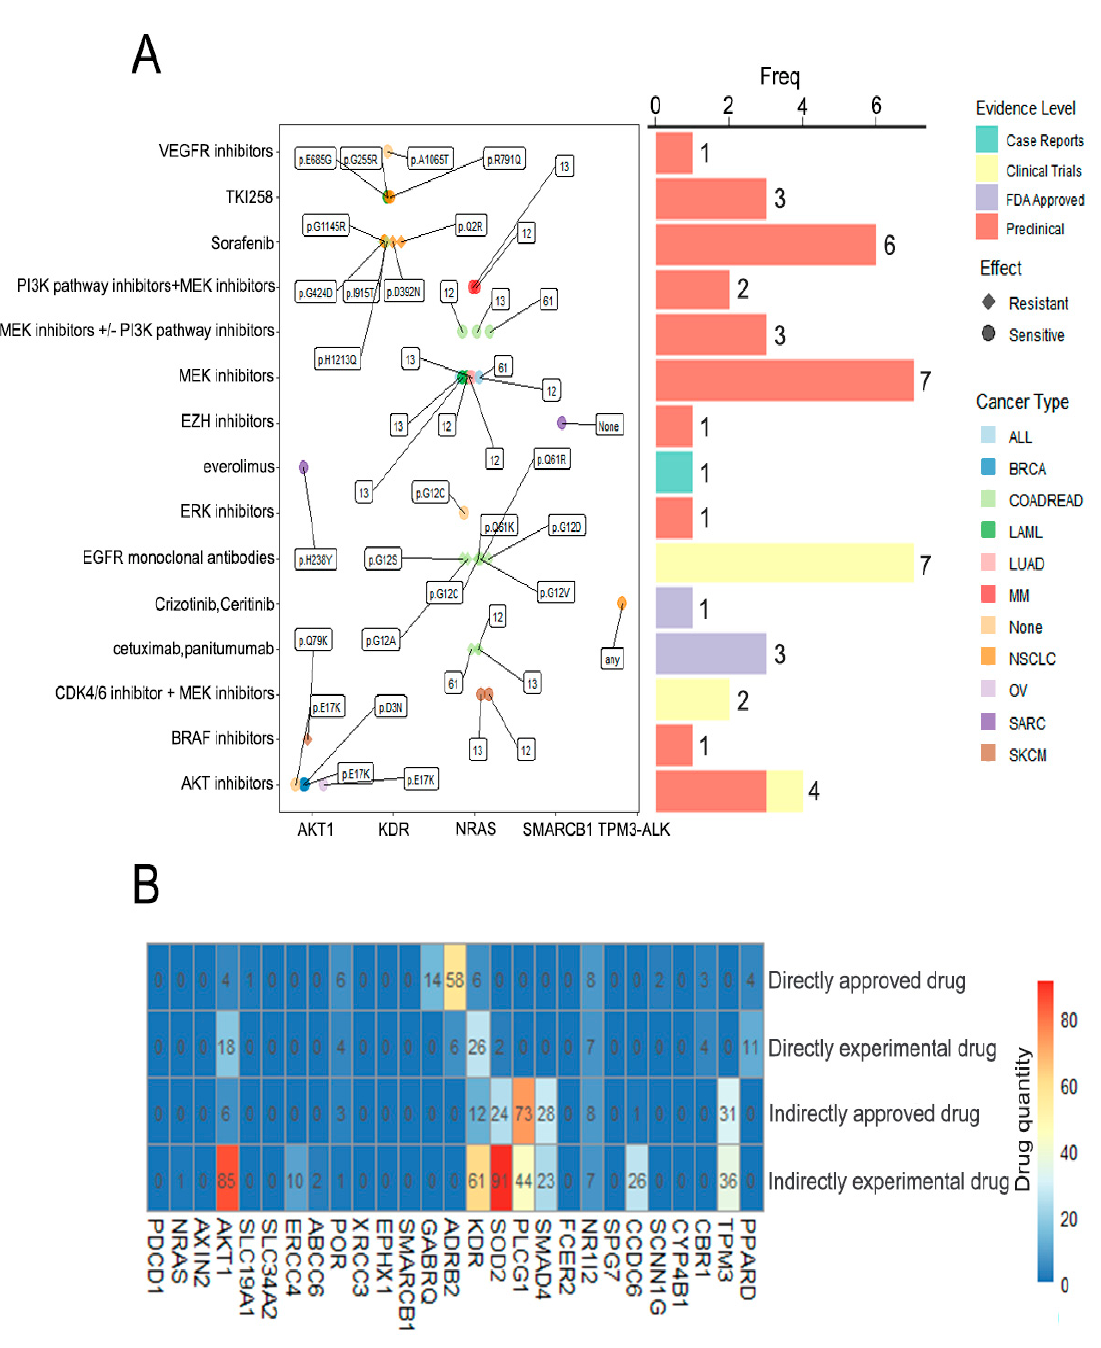
Figure 6. Drug analysis of 27 shared genes. ( A ) Drugs related to 27 common genes in the DEPO drug database. A total of 5 genes among these 27 common genes had related drugs. ( B ) Drugs related to 27 common genes in DRUGSURV drug database. A total of 18 genes had drugs that were directly or indirectly related.